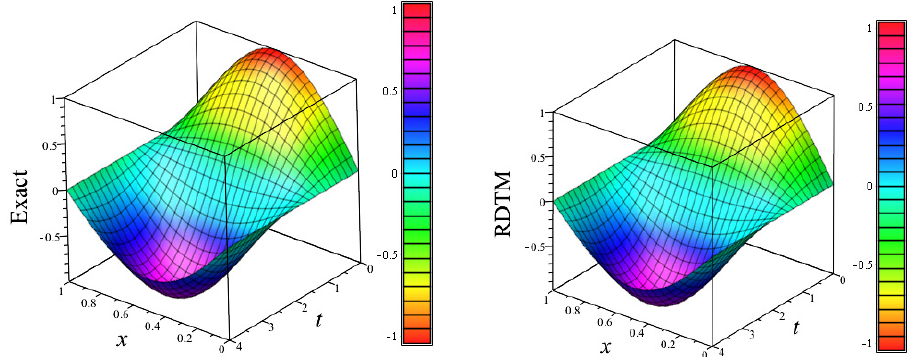
Figure 12. 3D plots of exact and approximate solution using RDTM, vs. x vs. t, for numerical experiment